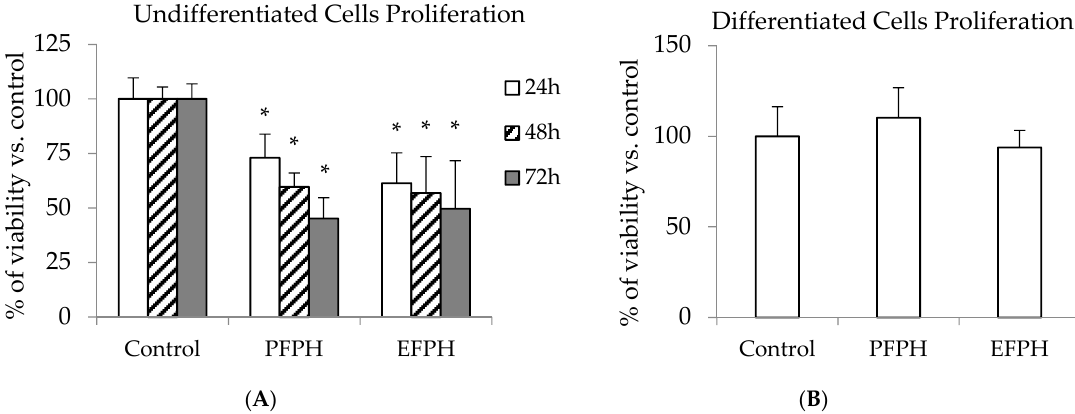
Figure 2. Relative viability of undifferentiated (( A ): 24 h, 48 h, and 72 h) and differentiated Caco2/TC7 cells ( B ) treated (24 h) or not with fenugreek proteins hydrolysates. Data are presented as mean ± SD. The experiment was done in triplicate (each performed with six determinations). Superscripted (*) means are significantly different ( p ≤ 0.05) compared to their respective control. Control: Untreated cells. PFPH: Purafect fenugreek proteins hydrolysate. EFPH: Esperase fenugreek proteins hydrolysate. The hydrolysates were used at a final concentration of 1 mg/mL.